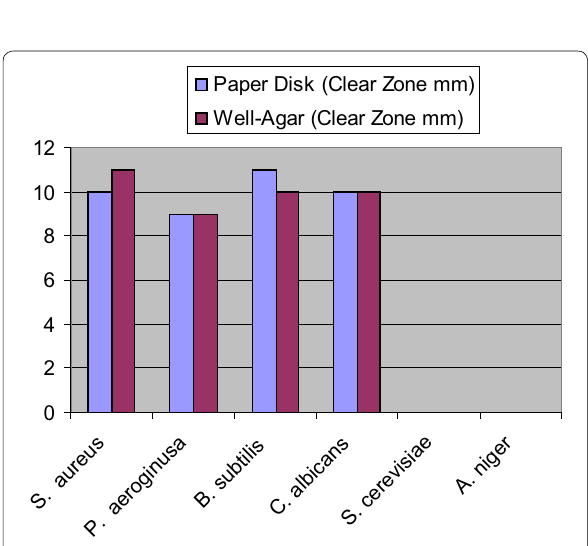
Fig. 1 Antimicrobial activity of compound 5a using agar disk diffu‑